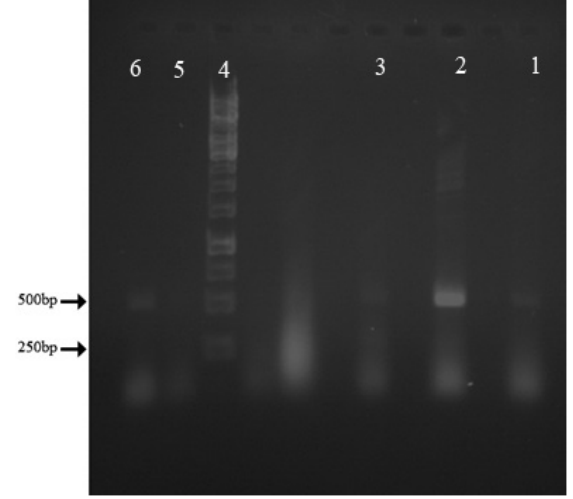
Figure 6. RT-PCR product on agarose gel 1% electrophoresis. Lines 1 and 3: RT-PCR product of untreated transfected samples. Line 2: Samples of transfected cells treated with 125 µM zinc sulfate, 2% glycerol, and 1% DMSO, line 4: 1kb DNA ladder. Line 5: Negative Control. Line 6: Positive Control. Figure 8. Western blotting analysis of hIFNβ -1a protein expression. Line 1: Sample containing supernatant of cells transfected without chemicals. Line 2: Sample containing the supernatant of transfected cells treated with chemicals. Line 3: Prestained protein ladder. Line 4: Negative Control.